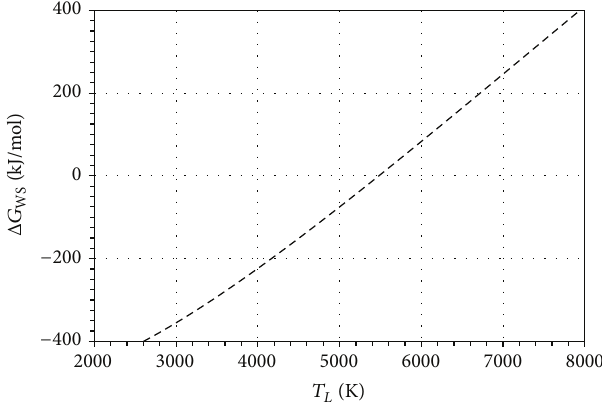
Figure 4: Variation in Gibbs free energy as a function of 𝑇 𝐿 for Tb- WS cycle.